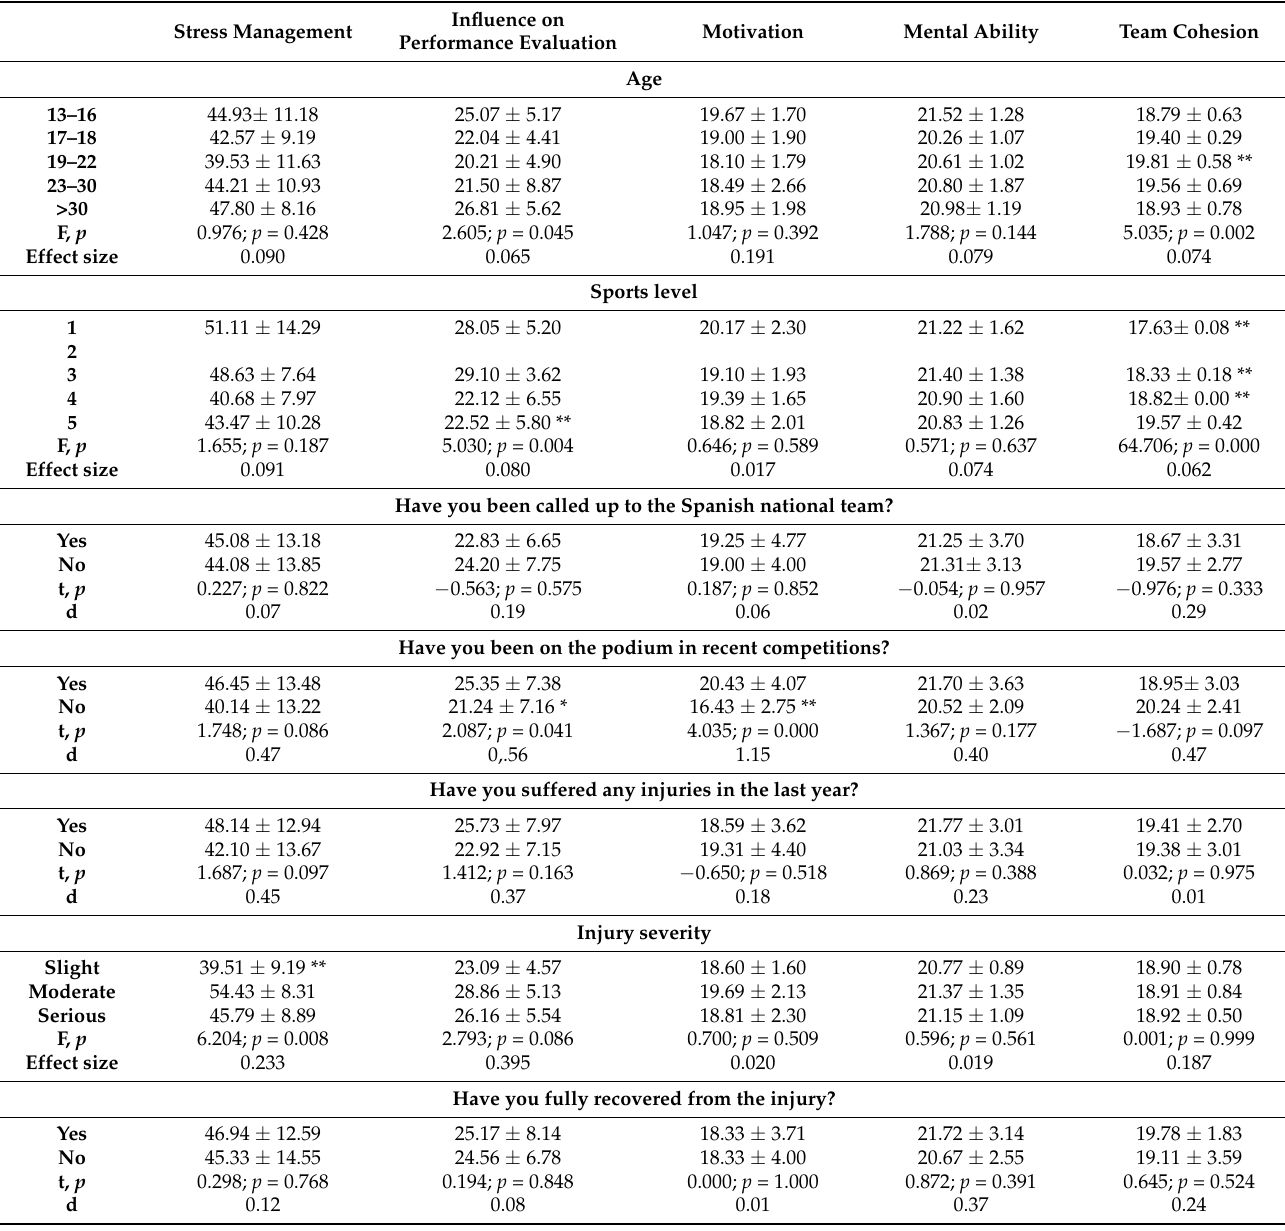
Table 2. Differences in the psychological profile of female cyclists according to sport modality, age, sport level, and injury severity (mean ± standard